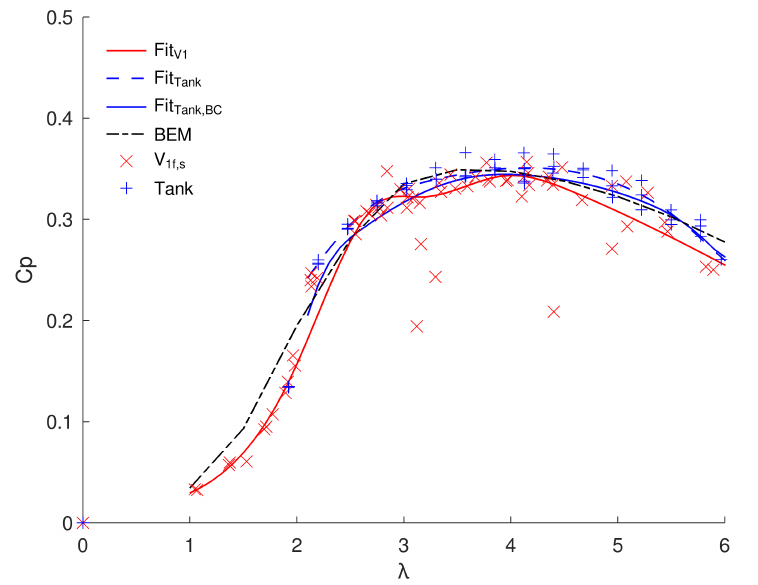
Figure 17. C p – λ curve obtained from field V1, filt and tank data. Lines were fitted as piecewise cubic splines using the GNUoctave splinefit function. Constraints are set to force the position (2,